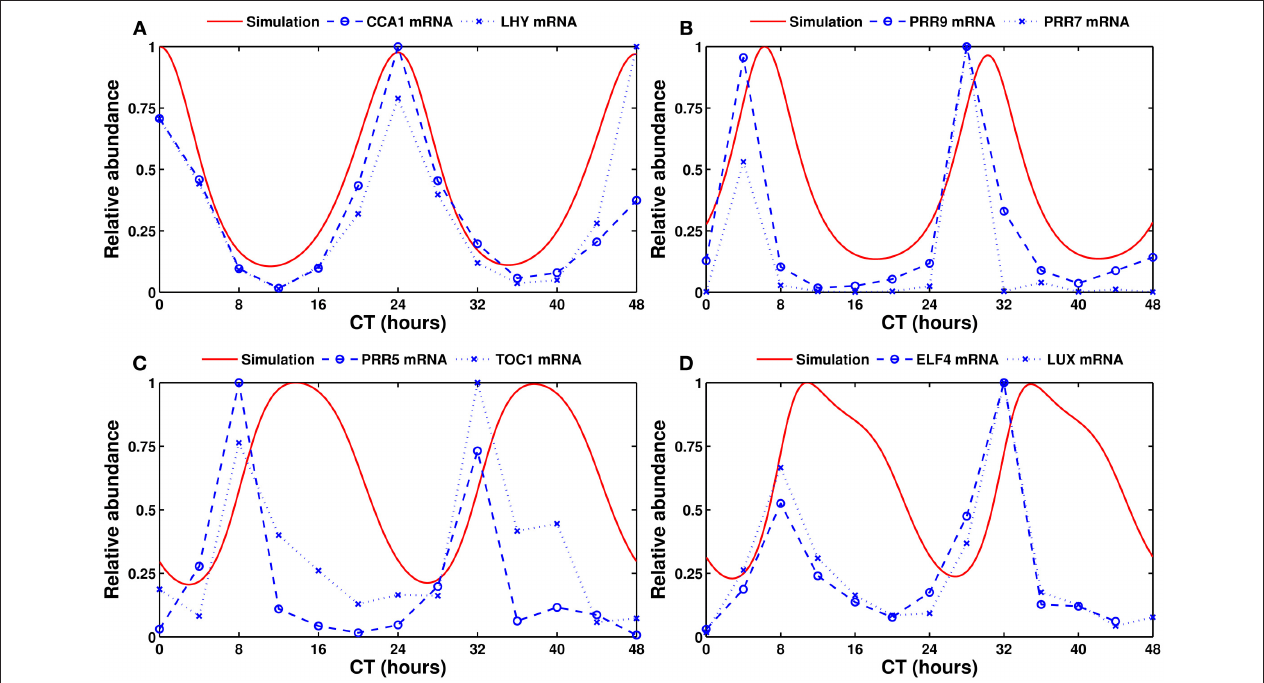
FIGURE 4 | Experimental and simulated expression profiles in continuous light conditions. Experimentally measured (in blue) and simulated (in red) mRNA levels of (A) CCA1 and LHY , (B) PRR9 and PRR7 , (C) PRR5 and TOC1 , and (D) ELF4 and LUX . All values are normalized to their respective maximum. The experimental data was obtained by qRT-PCR (see Section